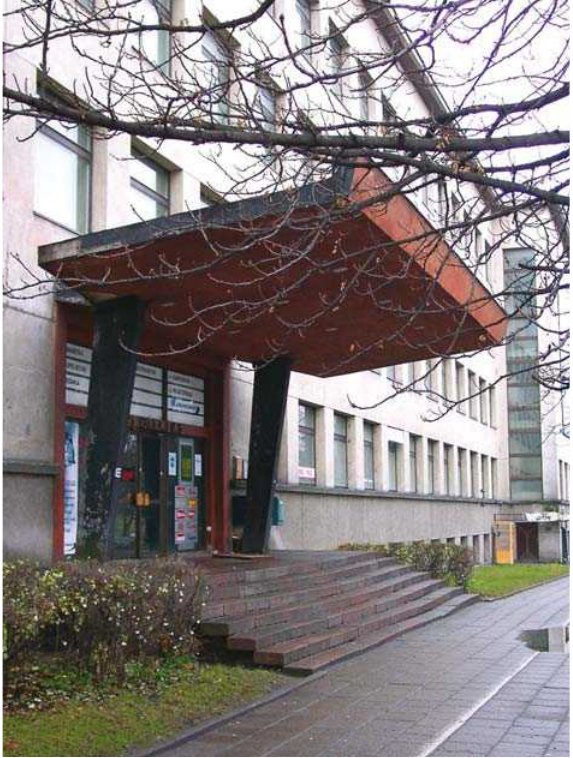
Fig 2. Institute of City Design. Arch E. Chlomauskas, 1961. Vilnius, Fig 3. Polyclinic. Arch S. Murczyński, J. Sołtan, 1937. Vilnius,